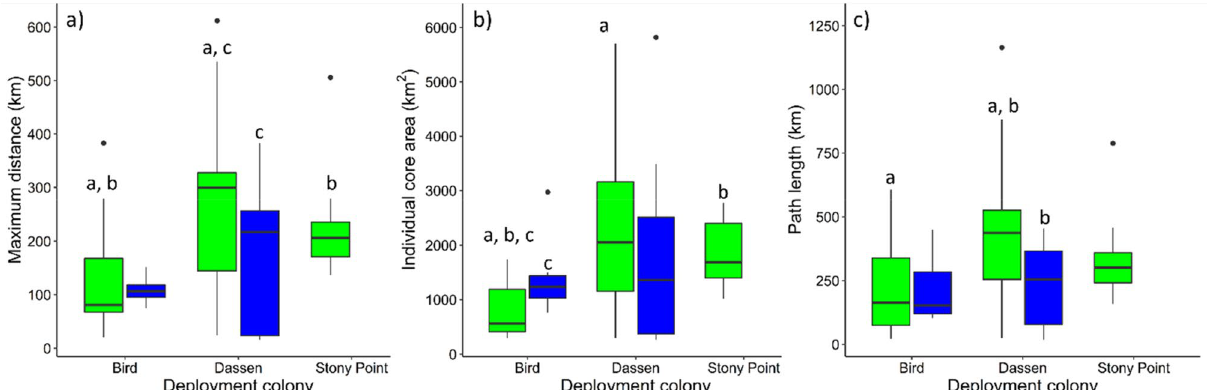
Figure 3. Box plots (median, interquartile (IQR 3 and IQR 4 ) range, minimum (IQR 3 * 1.5) and maximum (IQR 4 ) values and outliers) showing inter-site comparisons of African penguin path metrics during pre-moult (green) and post-moult (blue) stages: ( a ) maximum distance travelled from deployment colony ( b ) area of individual core areas (i.e. 54% utilisation distribution—UD), and ( c ) path length of maximum distance travelled from deployment colony. Letters indicate a p-value of < 0. 05 between colony or stages comparisons investigated using a PERNOVA or Dunn’s test were appropriate.